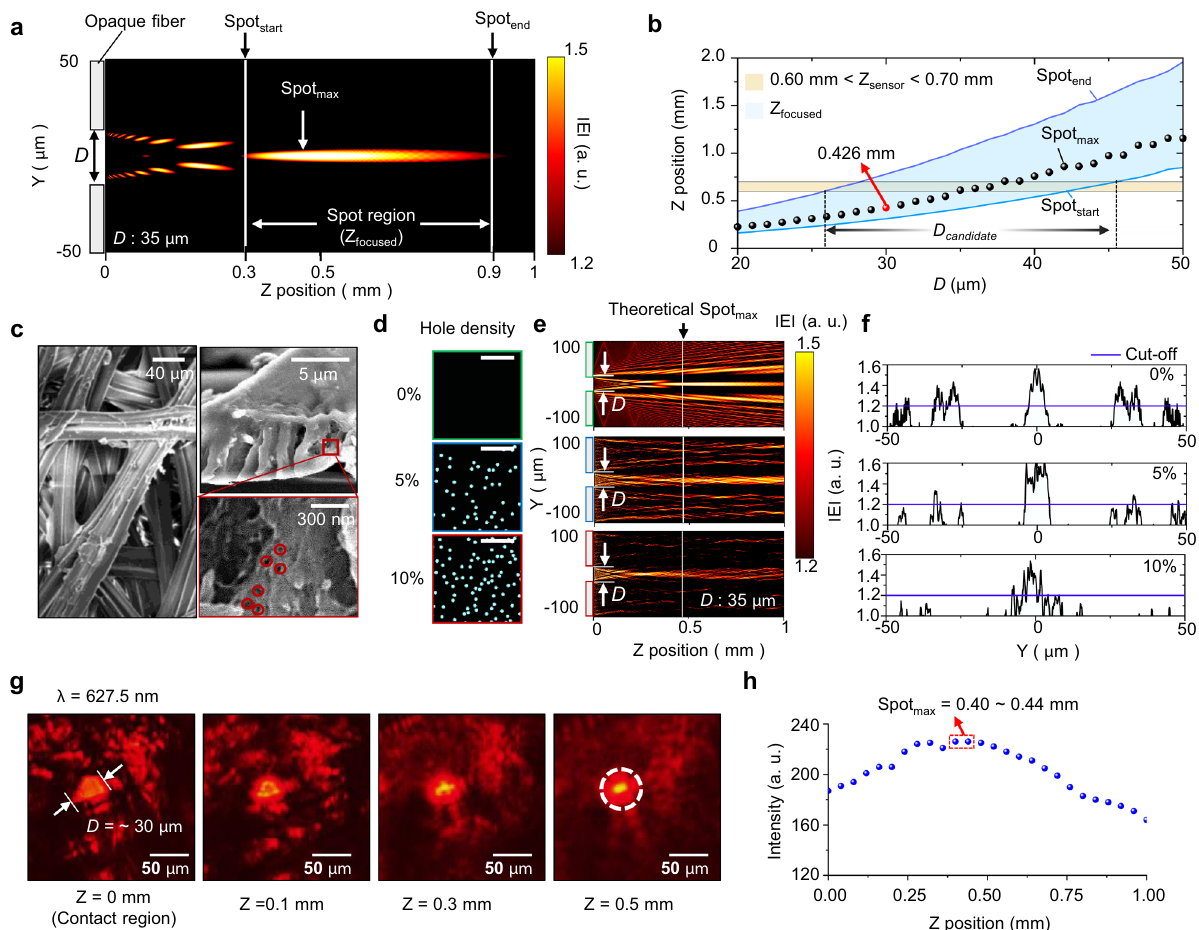
Fig. 2 Theoretical and experimental analyses on the self-focusing of fi brous media. a Optical simulation of an opaque fi ber with an opening diameter of 35 μ m under a wavelength of 645 nm. Fraunhofer diffraction forms an intense spot within a certain spatial range, which is called the ‘ Spot region ’ . The ‘ Spot region ’ is de fi ned from the Z positions of ‘ Spot start ’ and ‘ Spot end ’ . ‘ Spot max ’ indicates the strongest focal spot. b Calculated spot information, including ‘ Spot ’ , ‘ Spot ’ , ‘ Spot ’ , and the ‘ Spot region ’ , depending on D . The ‘ Spot region ’ is marked in blue. The active pixel of the image sensor is located at start end max 725 ± 75 µ m, which is noted by ‘ Z sensor ’ and highlighted in yellow. The overlapping region of the Z position with the ‘ Spot region ’ and ‘ Z sensor ’ is de fi ned as ‘ D ’ which ranges from 27 to 48 µ m. c Scanning electron microscope images of silk fi bers. d Refractive index pro fi le of three media with different hole candidate density levels (i.e., 0, 5, and 10%). The black and bluish green colors refer to the refractive indices of 1.5 and 1, respectively. The scale bar is 200 nm. e Electric fi eld distributions for three fi ber media. f Cross-sectional amplitude pro fi les of three results. g Measured data of the silk sample according to the depths (0, 0.1, 0.3, and 0.5 mm). h Intensity of the measured data. The maximum intensity of 226 is observed at the Z positions of 0.40 and 0.44